Question: What does this figure show? Answer in one sentence.
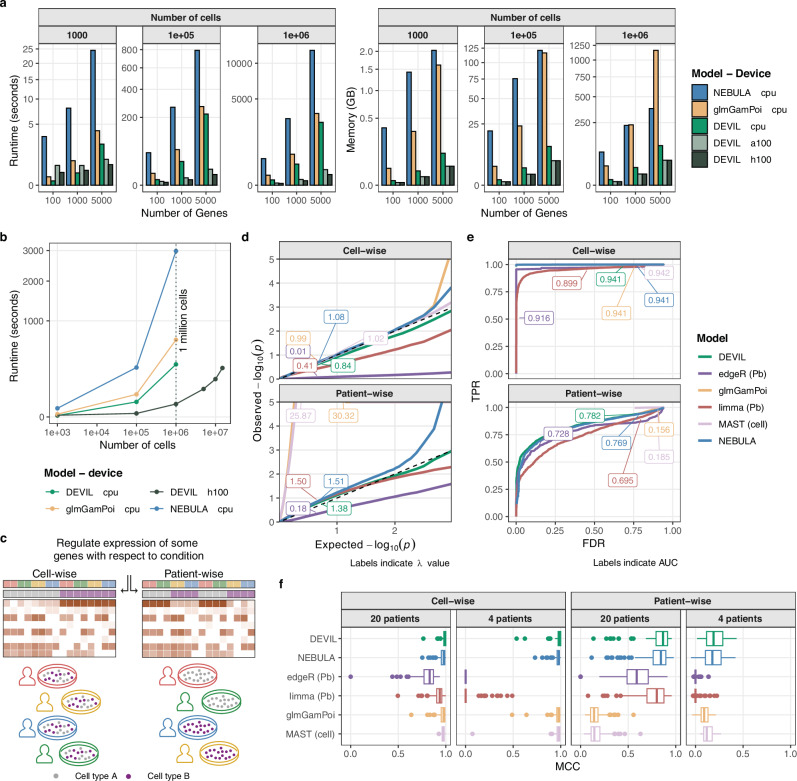
Answer: Performance and accuracy of DEVIL against state-of-the-art tools for scDE testing. a Runtime and memory used by DEVIL as compared to glmGamPoi and NEBULA, for different input-dataset dimensions. Both CPU and GPU implementations of DEVIL are considered, as well as two distinct GPU architectures. DEVIL is both faster and more memory efficient. b Absolute run-times with an input dataset of 1000 genes and a growing number of cells. The GPU implementation enables the analysis of up to 15 million cells. c Two contrasting experimental setups are considered for benchmarking multi-patient datasets. In the cell-wise design, both experimental conditions (e.g., cell types A and B) are represented within each patient, allowing within-patient comparisons that naturally control for inter-patient variability. In contrast, the patient-wise design assigns each condition to a distinct group of patients (i.e., each patient harbors only one condition), mimicking scenarios such as case-control studies or treatment comparisons across individuals. The latter introduces a complete confounding between condition and patient identity. d , e QQ-plot ( d ) of expected vs. observed −log 10 P values for non-differentially expressed genes, with the inflation factor \documentclass[12pt]{minimal} \usepackage{amsmath} \usepackage{wasysym} \usepackage{amsfonts} \usepackage{amssymb} \usepackage{amsbsy} \usepackage{mathrsfs} \usepackage{upgreek} \setlength{\oddsidemargin}{-69pt} \begin{document}$${{{\rm{\lambda }}}}$$\end{document} λ reported for each tool, and TPR/FDR curve ( e ) showing power of each tool for a nominal FDR threshold, with AUC values reported. DEVIL exhibits near-uniform distributions under the null hypothesis, while maintaining high power in detecting true DE genes. f Performance evaluation using Matthews Correlation Coefficient (MCC) across varying numbers of patients (4 and 20) and experimental settings. DEVIL and NEBULA achieve top performances on both experimental settings. Boxes s